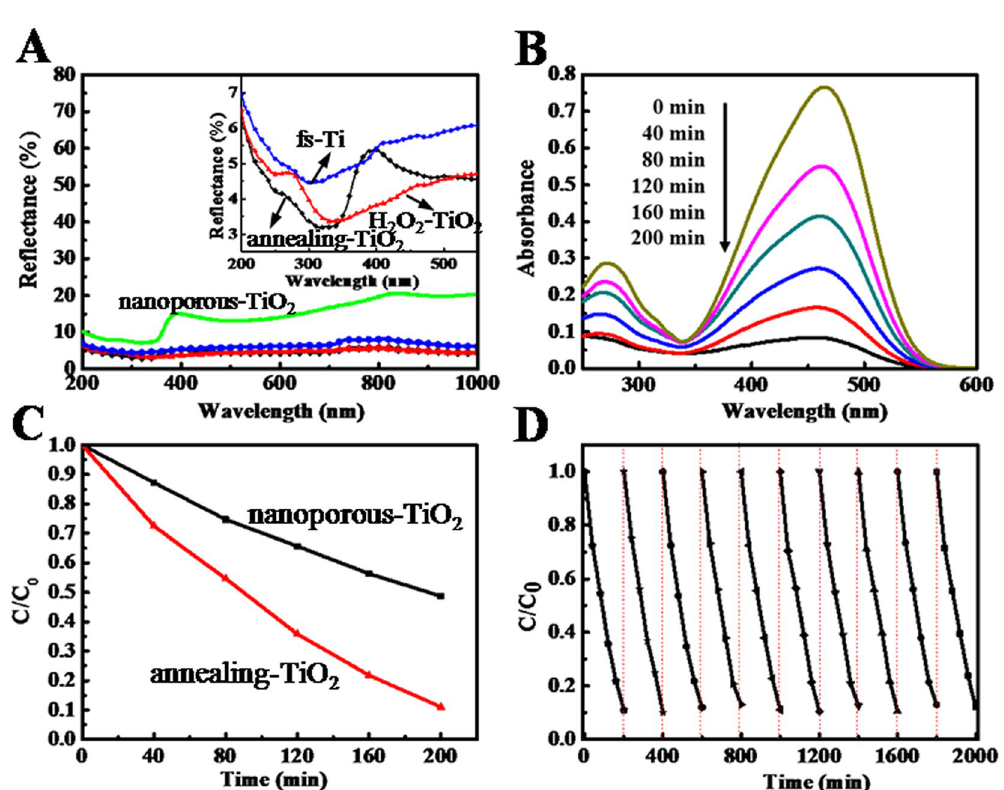
Figure 5. ( A ) Reflection spectra of nanoposours-TiO 2 , fs-Ti, H 2 O 2 -TiO 2 and annealing-TiO 2 , ( B ) Temporal UV-visible adsorption spectral of annealing-TiO 2 changes for the methyl orange solution as a function of UV (365 nm) irradiation time, ( C ) Comparison of photocatalytic degradation rates of methyl orange between nanoporous-TiO 2 structure and annealing-TiO 2 , ( D ) Cycling degradation curve of annealing-TiO 2